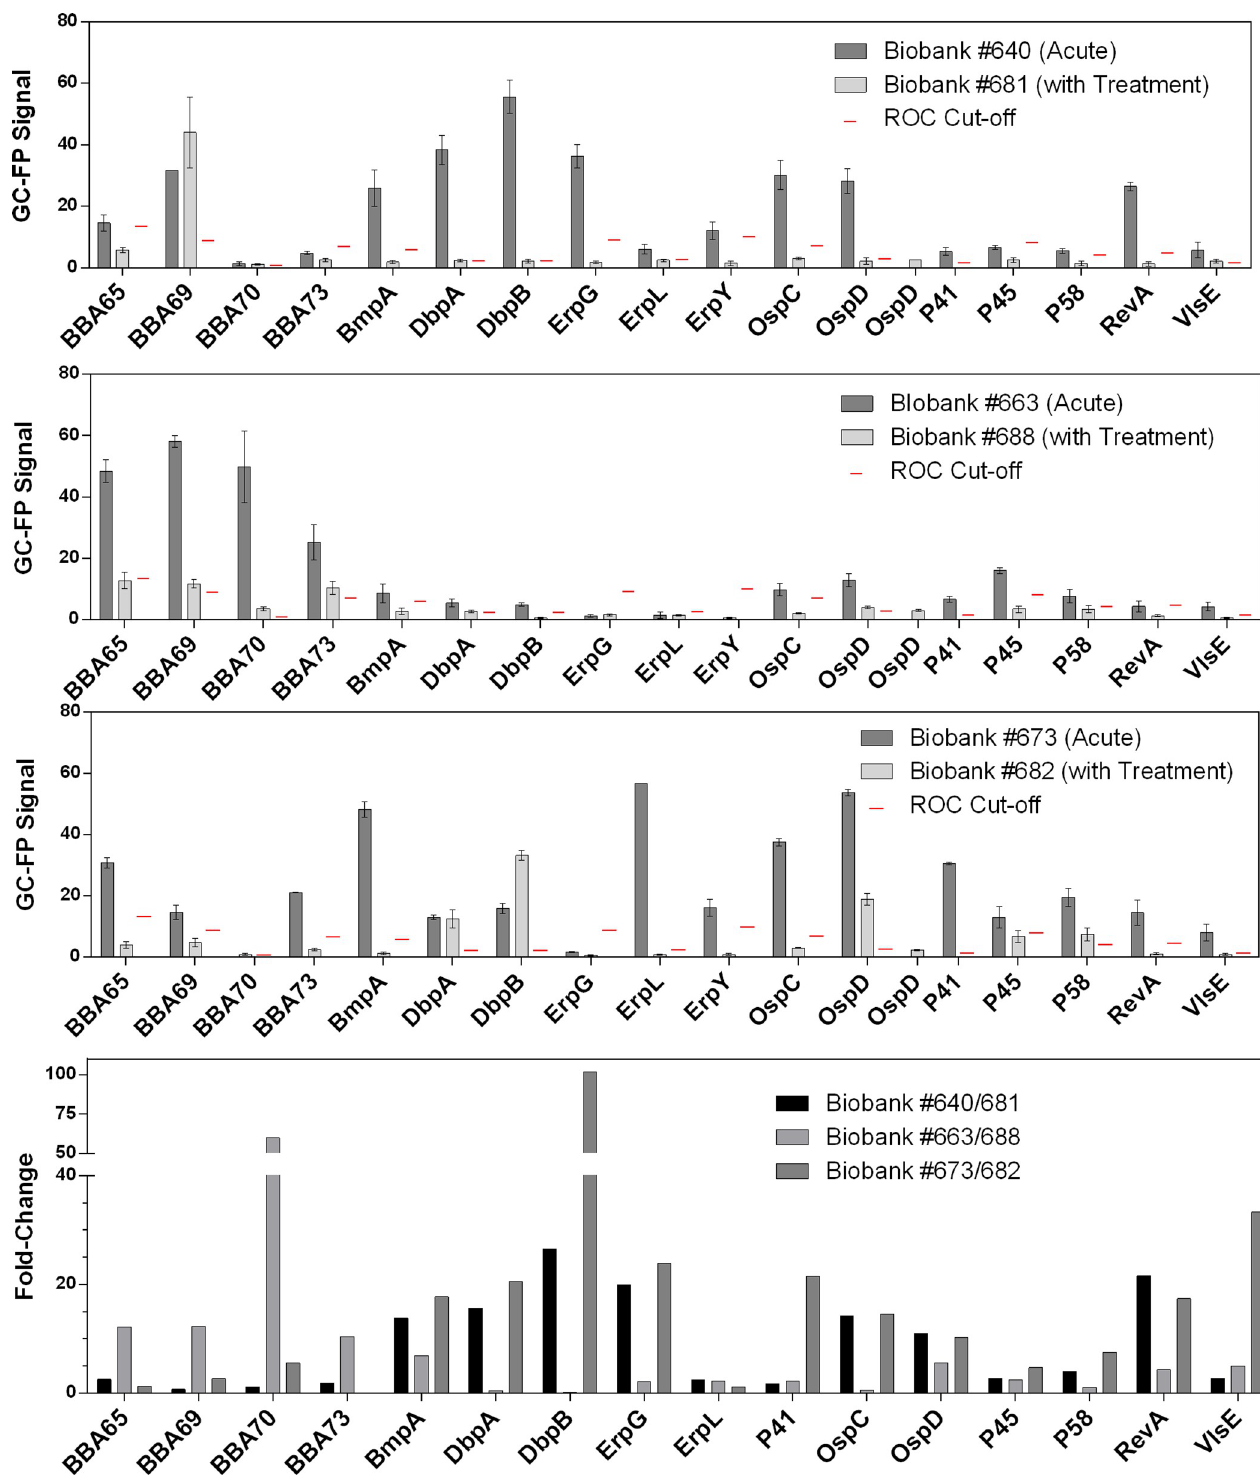
Fig 6. IgG serum profile following antibiotic treatment. The mean GC-FP signals ± Standard Error of the Mean for 16 antigens are shown for three acute and convalescent serum pairs. The ROC cut-offs (red lines) provide a reference to determine whether a measured antibody binding response may be considered “positive” for each serum sample. The fold change between acute and convalescent samples are also shown for each serum pair (bottom panel).